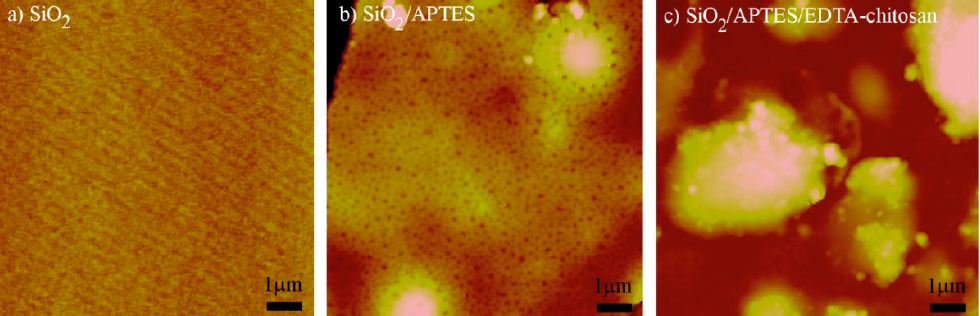
Figure 2. Fourier-transform infrared spectroscopy (FTIR) spectra of: ( a ) Silica substrate; ( b ) chitosan-conjugated EDTA treated silica surface.